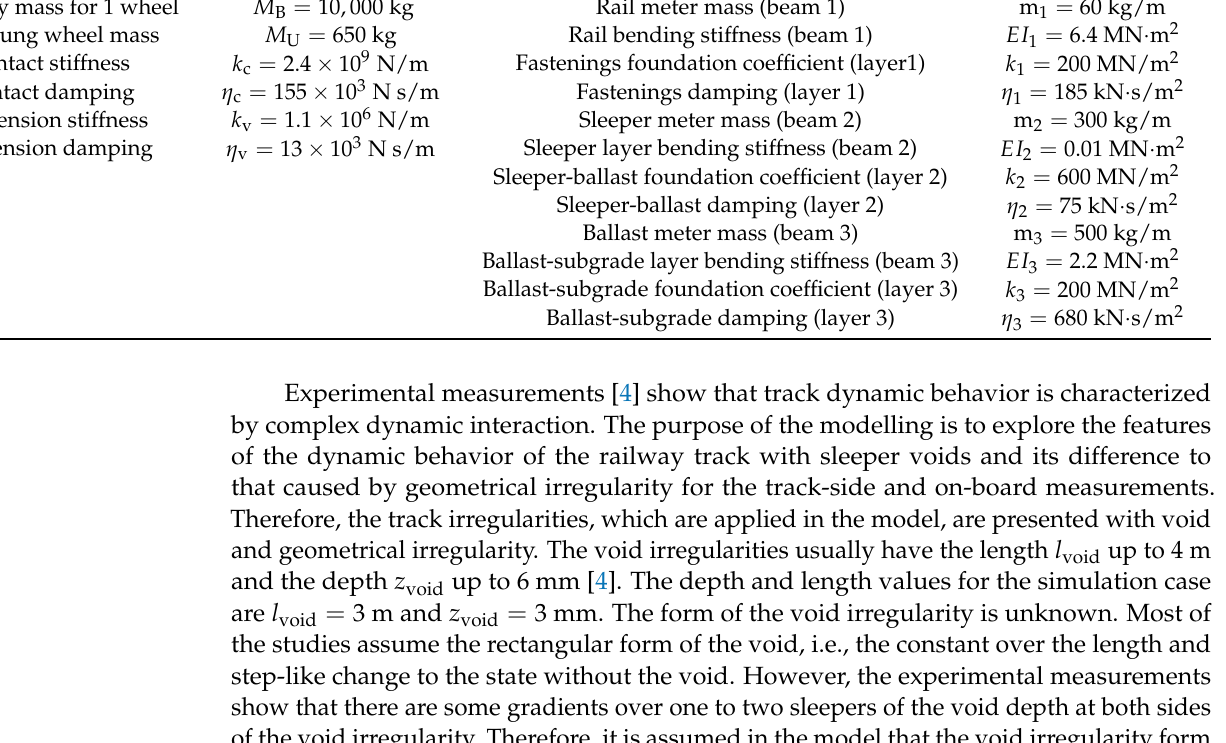
Table 1. Parameters of the dynamic model.